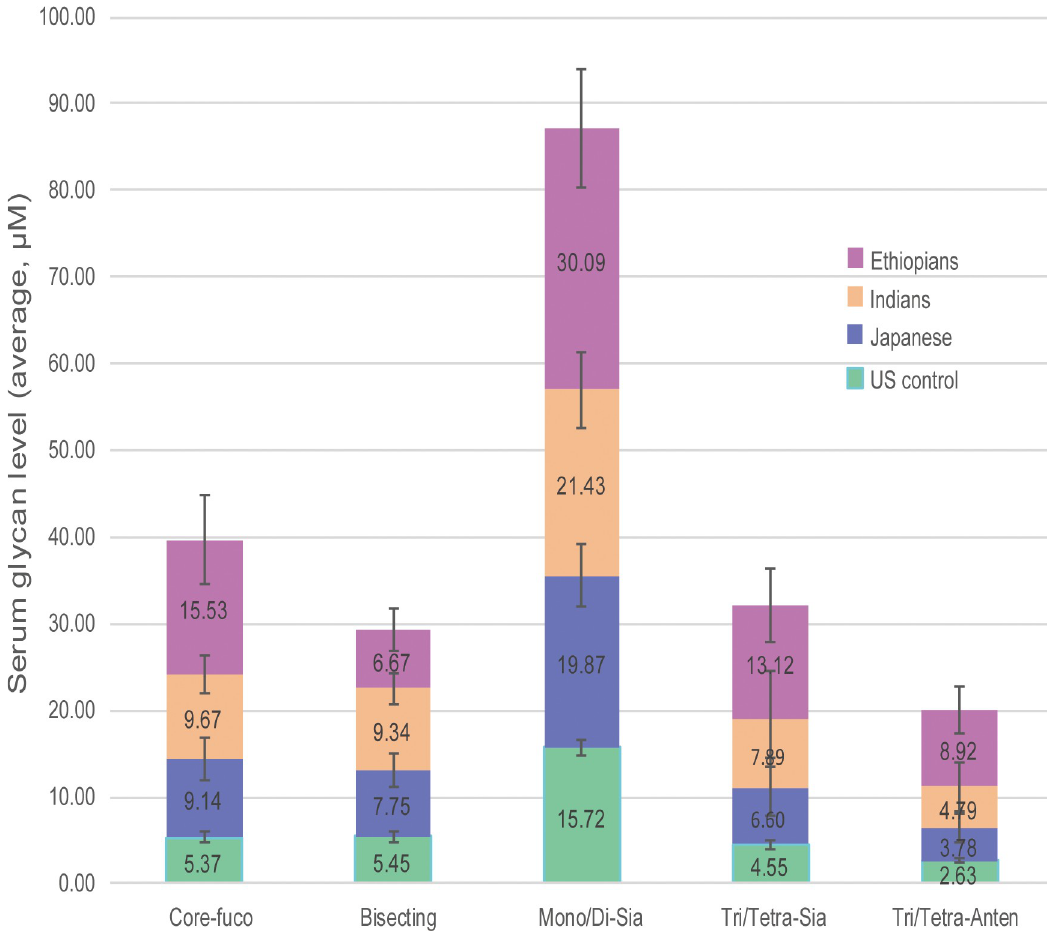
Fig 7. Ethnic-based serum level of some common glyco-subclasses. N -glycans were grouped in terms of core-fucosylation, bisecting, mono- or di-sialylation, tri-or tetra-sialylation, tri- or tetra-antennary features. Error bars indicate standard errors of the